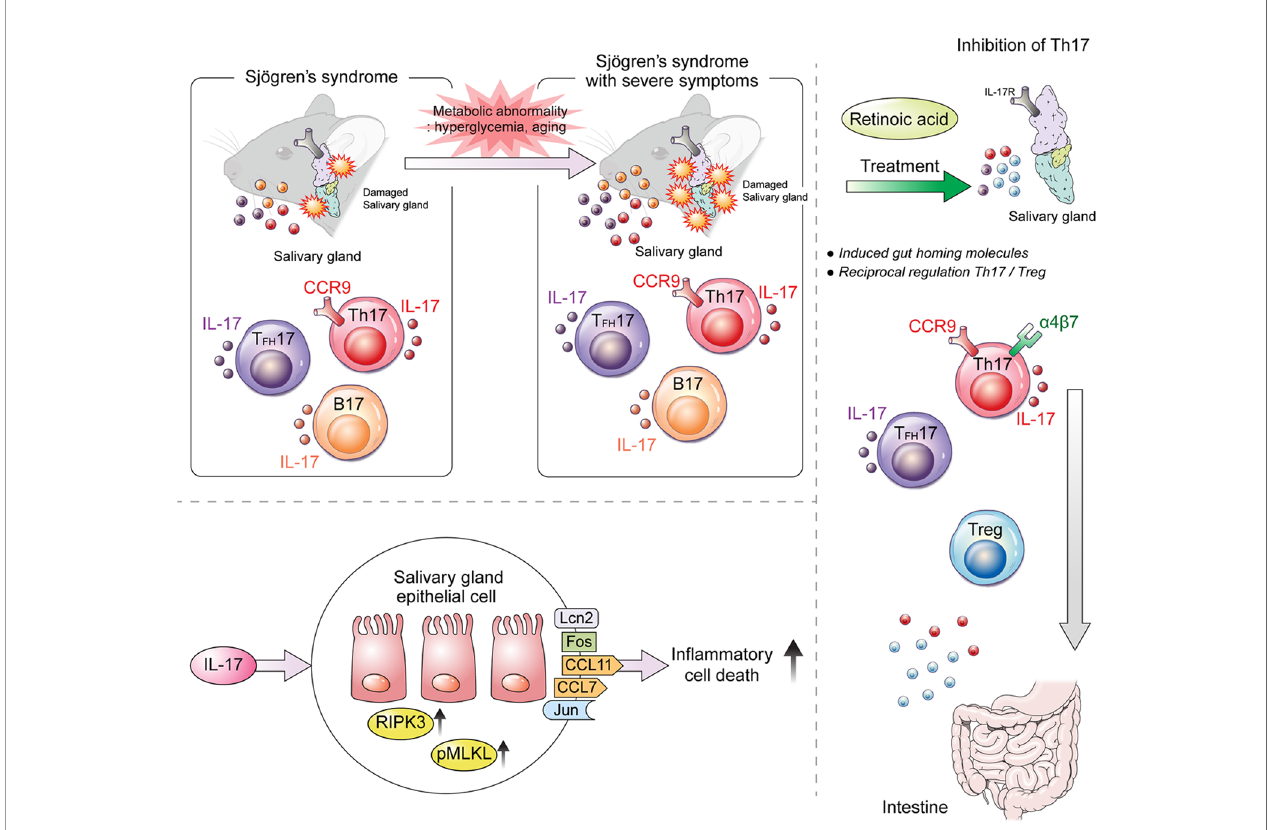
FIGURE 7 | Graphical summary of the fi ndings of the present study. Our study demonstrates that IL-17 and CCR9 + a 4 b 7 – Th17 cells promote salivary gland in fl ammation and dysfunction in SS. RA ameliorates aging- and metabolic-abnormality-induced salivary gland in fl ammation by inducing gut-homing CCR9 + a 4 b 7 + Th17 and Treg cells in